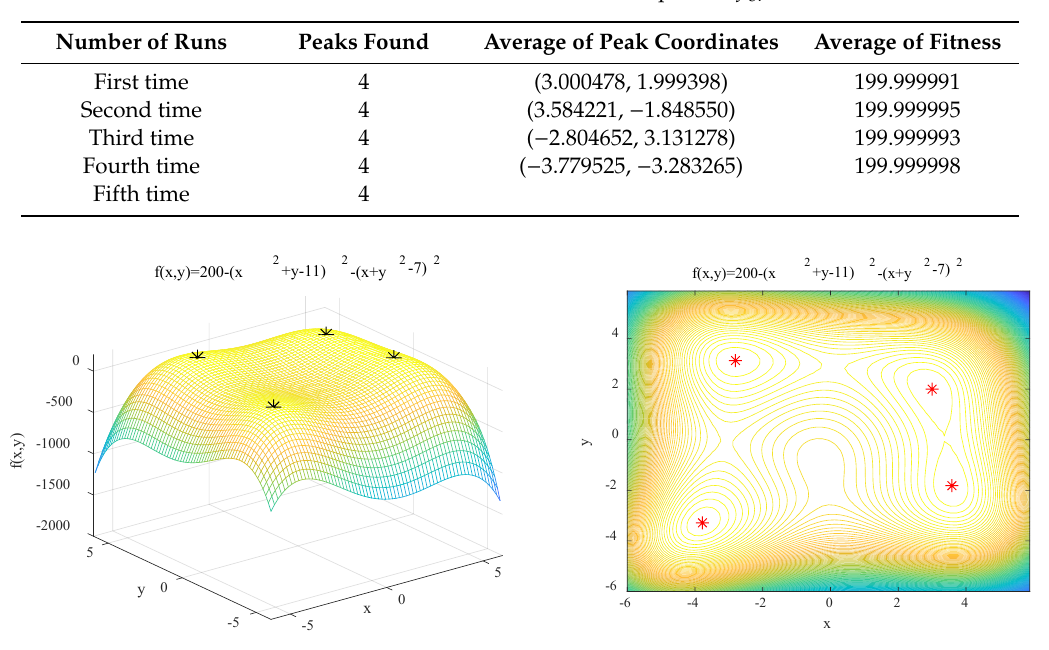
Figure 8. Results of performing IAFSA once to find the peaks of f 2 .